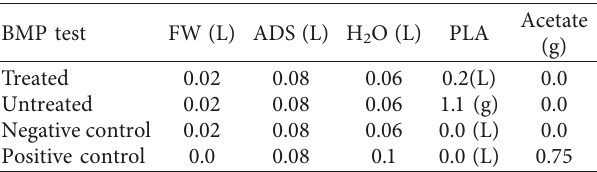
Table 2: Volumes and mass of polylactic acid (PLA) and mass of acetate used for experiments with food waste (FW) and anaerobic digested sludge